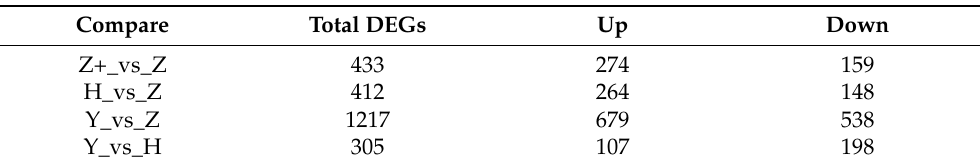
Figure 2. Volcano Polt of differentially expressed genes (DEGs). ( a ) Comparsion of self-root cucumber with silicon addition (Z+) and self-rooted cucumber (Z); ( b ) comparsion of ‘Huangchenggen No. 2 ′ -grafted cucumber (H) and self-rooted cucumber (Z); ( c ) comparsion of ‘Yunnan figleaf gourd’-grafted cucumber (Y) and self-rooted cucumber (Z); ( d ) comparsion of ‘Yunnan figleaf gourd’-grafted cucumber (Y) and ‘Huangchenggen No. 2 ′ -grafted cucumber (H). The red column indicates the number of upregulated genes, whereas the blue one means downregulated genes. Table 1. Number of differentially expressed genes (DEGs) in cucumber leaves. Different treat- ments represent: self-rooted cucumber (Z), self-rooted cucumber with silicon addition (Z+), ‘Huangchenggen No. 2 ′ -grafted cucumber (H) and ‘Yunnan figleaf gourd’-grafted cucumber (Y). The former is the treatment, whereas the latter is the control.